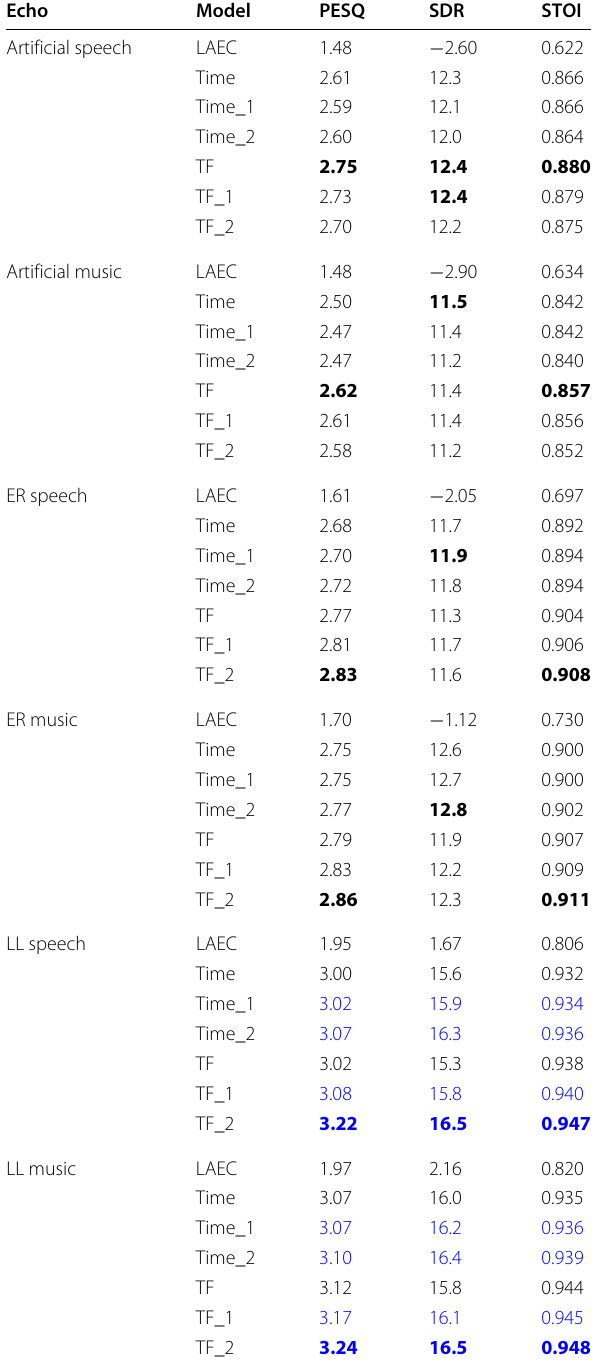
Table 4 Performance of the pre-trained model and the fine-tuned models with LL recorded echo Echo